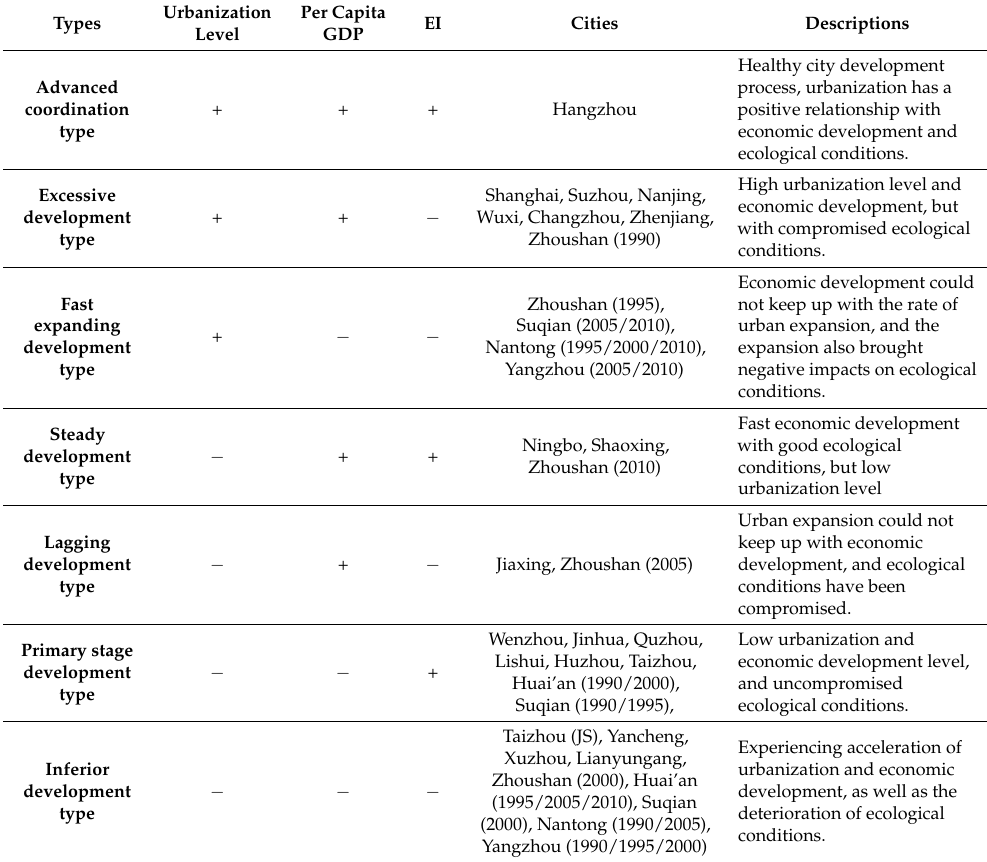
Table 2. Urban development mode in the YRD during